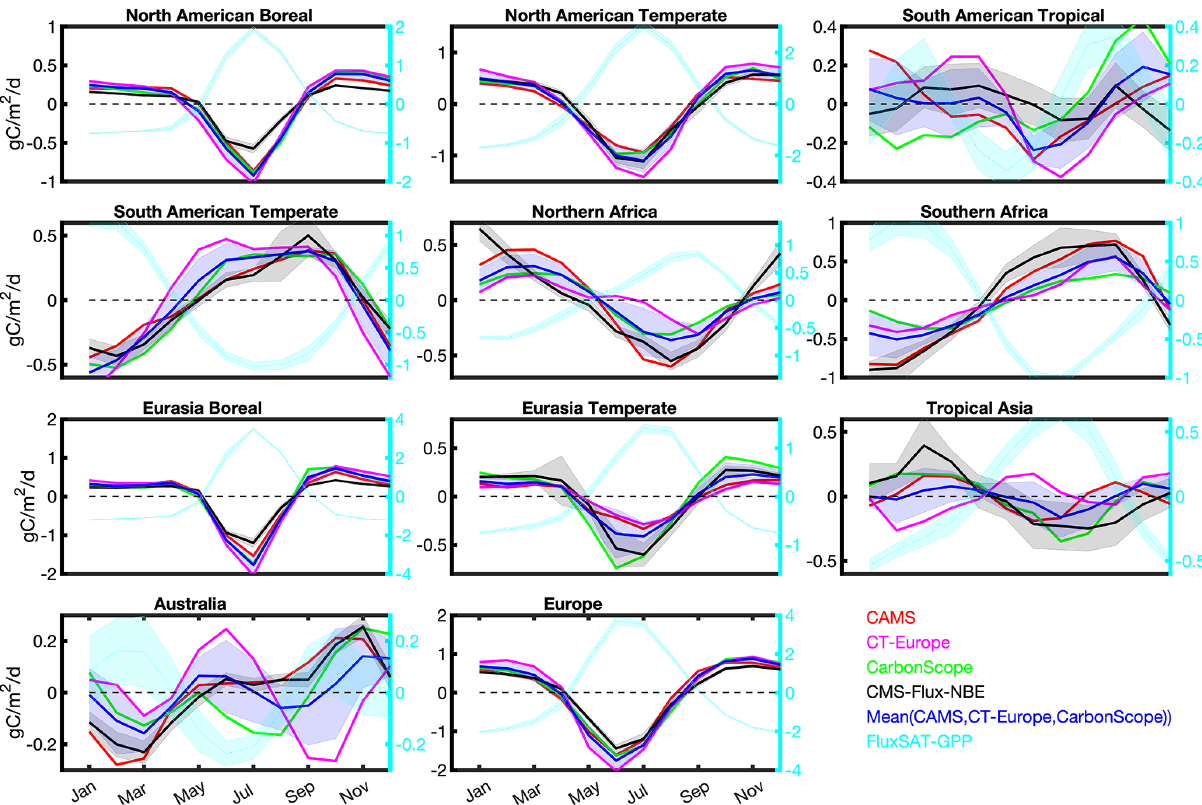
Figure 8. The NBE climatological seasonality over TransCom regions. The seasonal cycle is calculated over 2010–2017 since CT-Europe only covers until 2017. Black: CMS-Flux NBE and its uncertainty; blue shaded: mean NBE seasonality based on surface CO 2 inversion results from CAMS, CT-Europe, and Jena CarbonScope; red: CAMS; magenta: CT-Europe; green: Jena CarbonScope. The names of each region are shown on individual